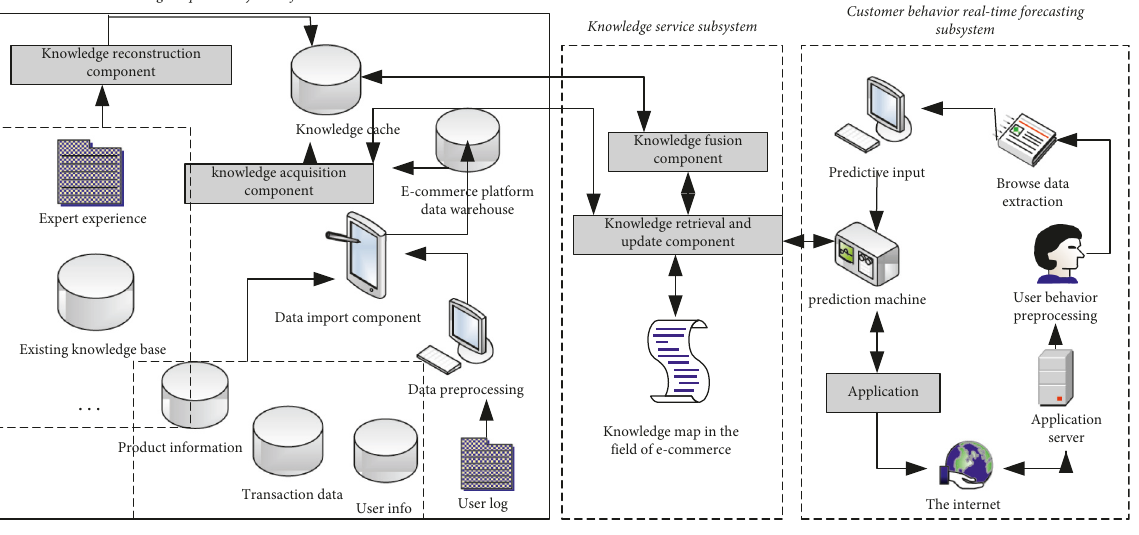
Figure 3: System architecture diagram.